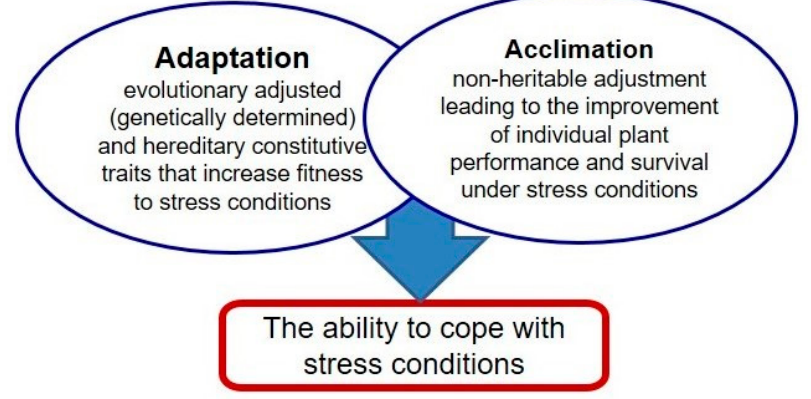
Figure 1. Stress adjustment developed in plants.